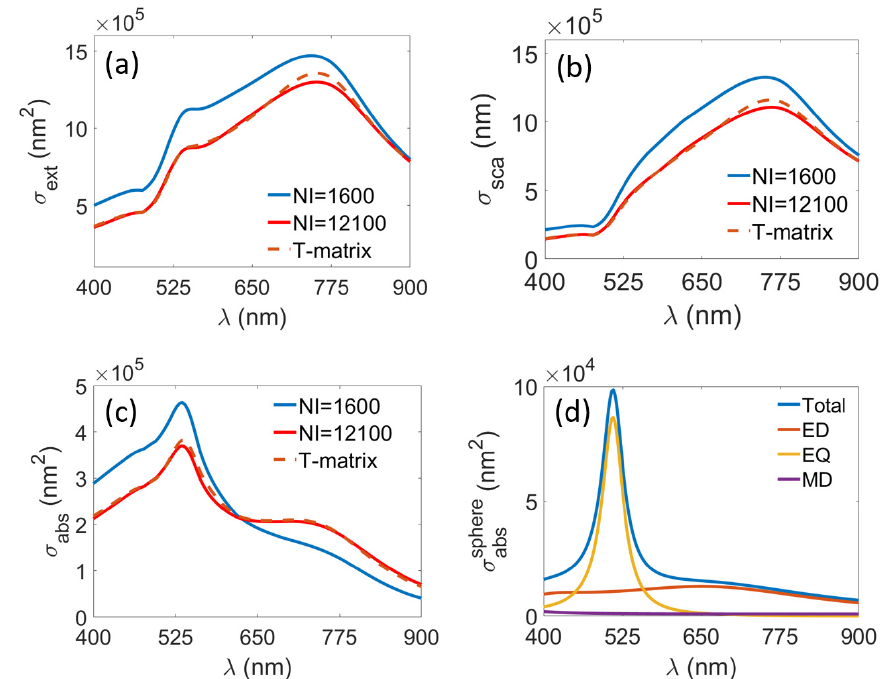
Figure 2. Average ( a ) extinction; ( b ) scattering; and ( c ) absorption cross section of gold nanospheres arranged in a helix. The blue straight lines denote the value extracted from manual averaging method with 1600 number of illumination (NI), the red straight lines using 12,100 NI, while the brown dashed lines are extracted directly from the T-matrix, as described in Table 1; and ( d ) absorption cross section of single gold sphere with radius 80 nm and it’s multipolar decomposition. ED, EQ and MD denote electric dipole, electric quadrupole and magnetic dipole,